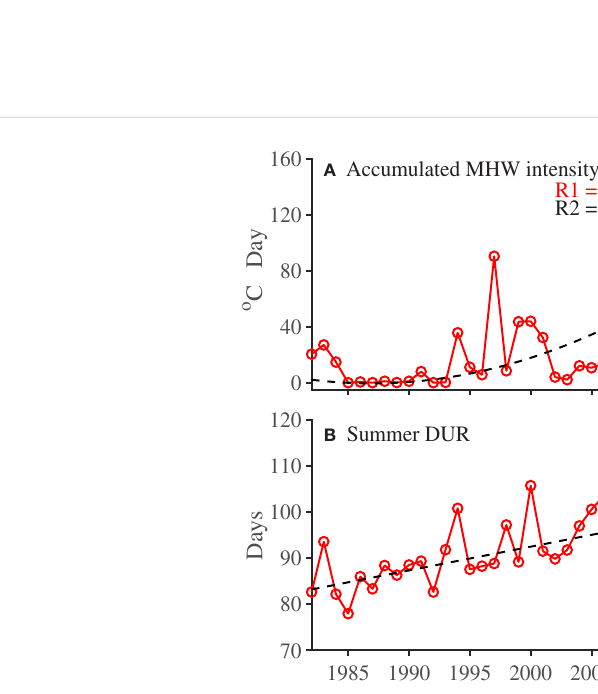
FIGURE 10 Time series of (A) the annually accumulated marine heatwave (MHW) intensity (unit: °C·day) and (B) the summer DUR (unit: days) averaged over the Bohai Sea during 1982 – 2019. Black curve represents the secular trend derived from the EEMD decomposition. Red number denotes the correlation coef fi cient between the original time series of the accumulated MHW intensity and that of the summer DUR; Black number denotes the correlation coef fi cient between the time series of corresponded secular